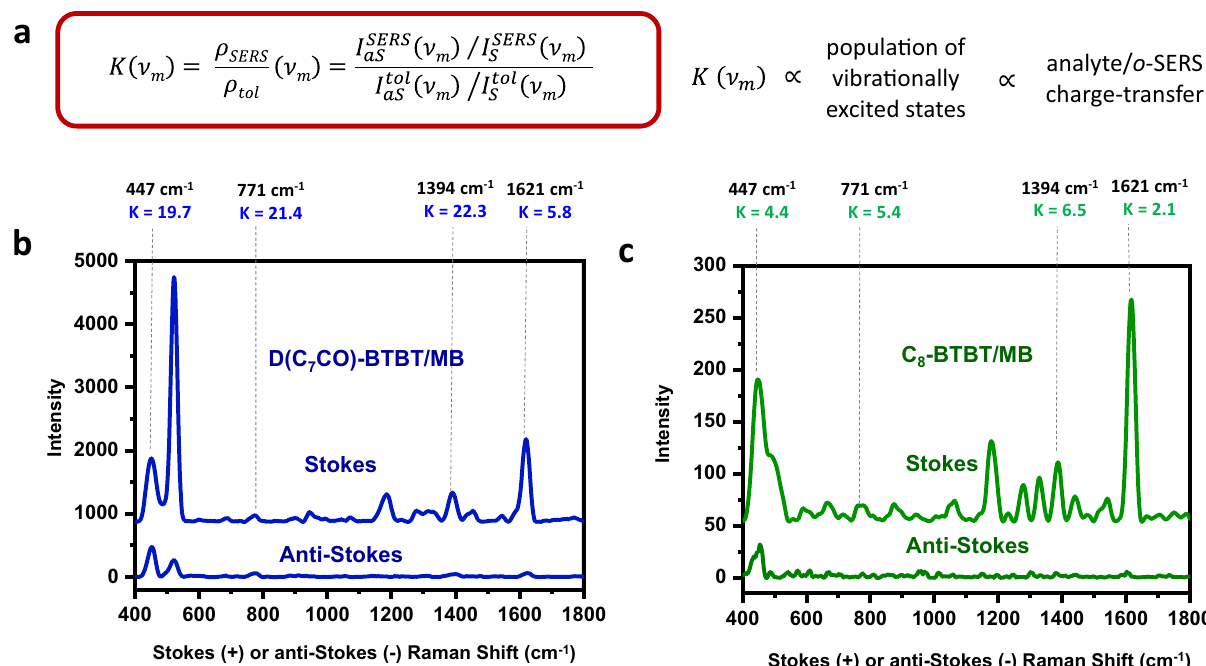
Fig. 7 Stokes vs. anti-Stokes Raman spectra for D(C 7 CO)-BTBT and C 8 -BTBT fi lms. a The equation describing the degree ( K ) by which the SERS anti- Stokes signal exceeded the expectation of the Boltzmann distribution. Stokes and anti-Stokes Raman spectra for D(C 7 CO)-BTBT/MB ( b ) and C 8 -BTBT/MB ( c ) analyte/ o -SERS systems, and the calculated K values for selected Raman peaks ( ν m ). I SERS aS and I SERS S are the observed anti-Stokes and Stokes signal intensities, respectively, for the analyte molecule on the current fi lms. I tol aS and I tol S are the anti-Stokes and Stokes signal intensities, respectively, for